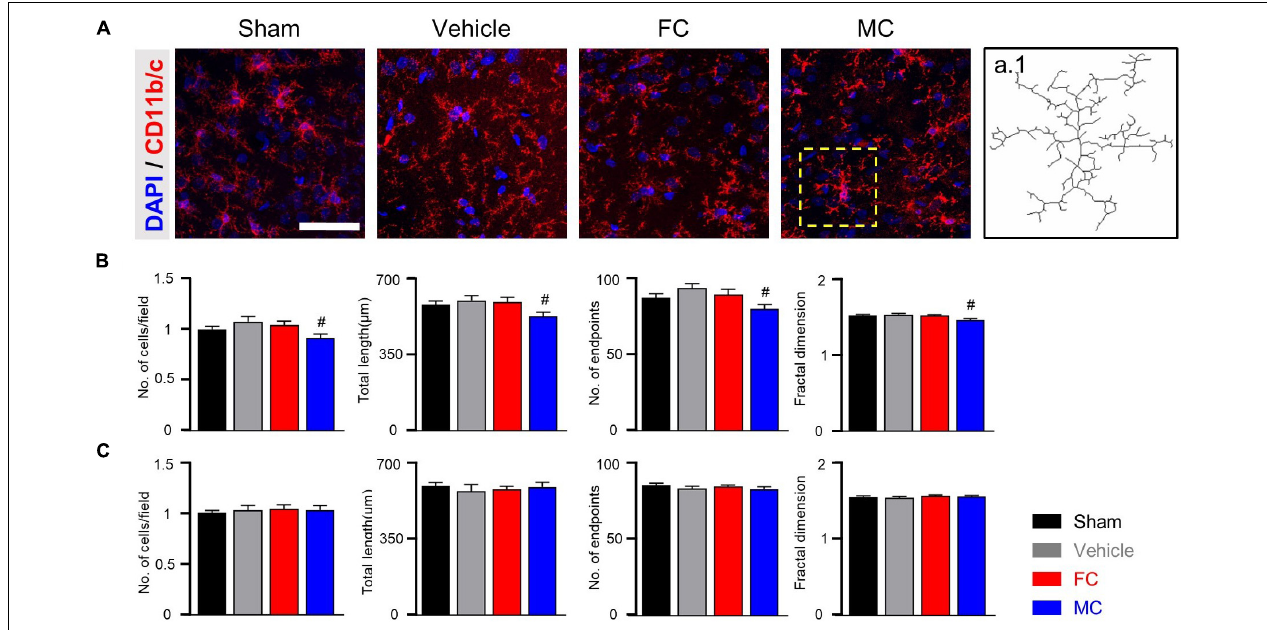
FIGURE 4 | Morphological changes in microglia after early inhibition. (A) Representative images of CD11b/c-positive microglia with DAPI in the IC on PID 7. Decreased ramification of microglia was observed in the MC-injected group compared to the vehicle group (a.1 represents the transformed skeletal image of microglia from yellow dotted box of the MC-treated group). Scale bar, 50 µ m. (B,C) MC inhibits morphological activation of microglia in the early stage of pain development ( B: PID 7; C: PID 14). Total length, number of end points, and fractal dimension were quantified by skeleton analysis and fractal analysis (sham, vehicle, FC, and MC: each group n = 4). Error bars are SEM. # p < 0.05 vs. vehicle, one-way ANOVA followed by Tukey’s post hoc multiple comparison